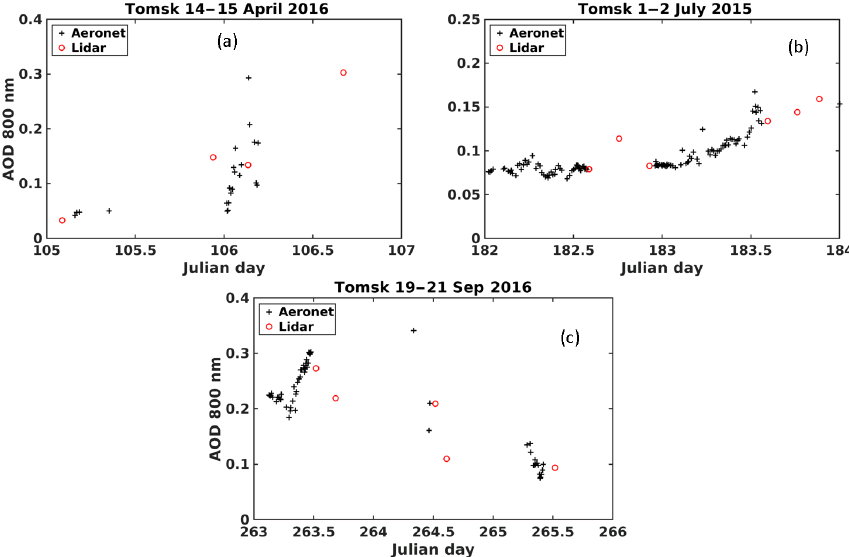
Figure 9. Diurnal evolution of the lidar AOD and the sun-photometer AOD at 808nm for A (b) , B (a) and C (c) cases shown in Fig. 8.